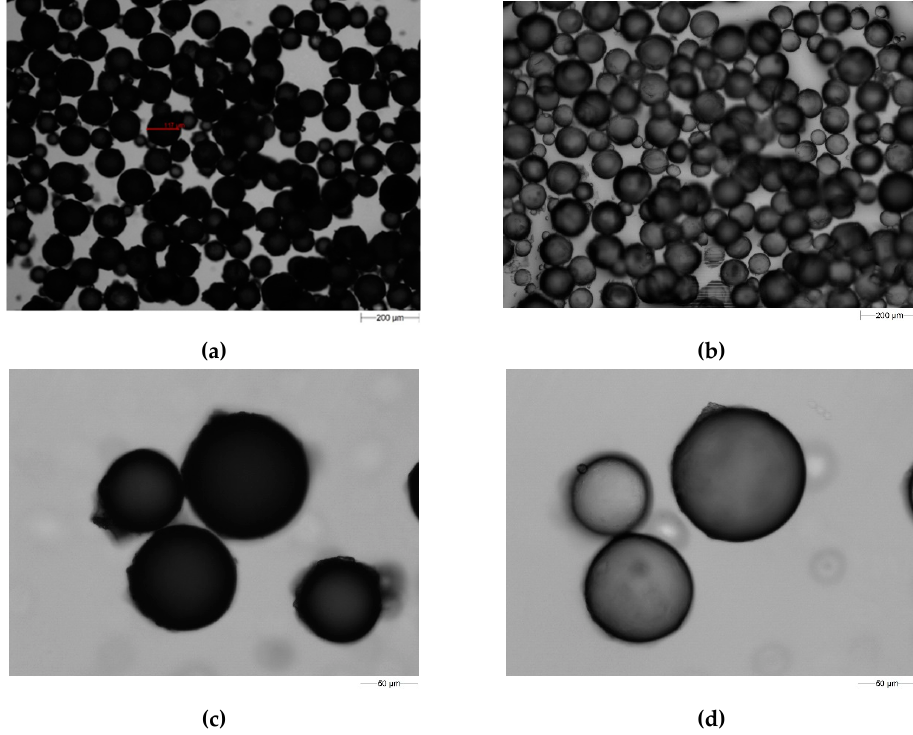
Figure 2. Photos of the synthesized microspheres ( a , c ) and ( b , d ) those swollen with acetone obtained using optical microscope Morphologi G3.